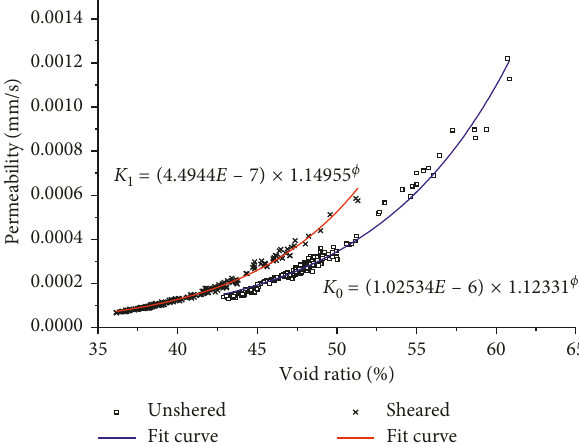
Figure 8: Pore fractal dimension of mud bed at different heights.